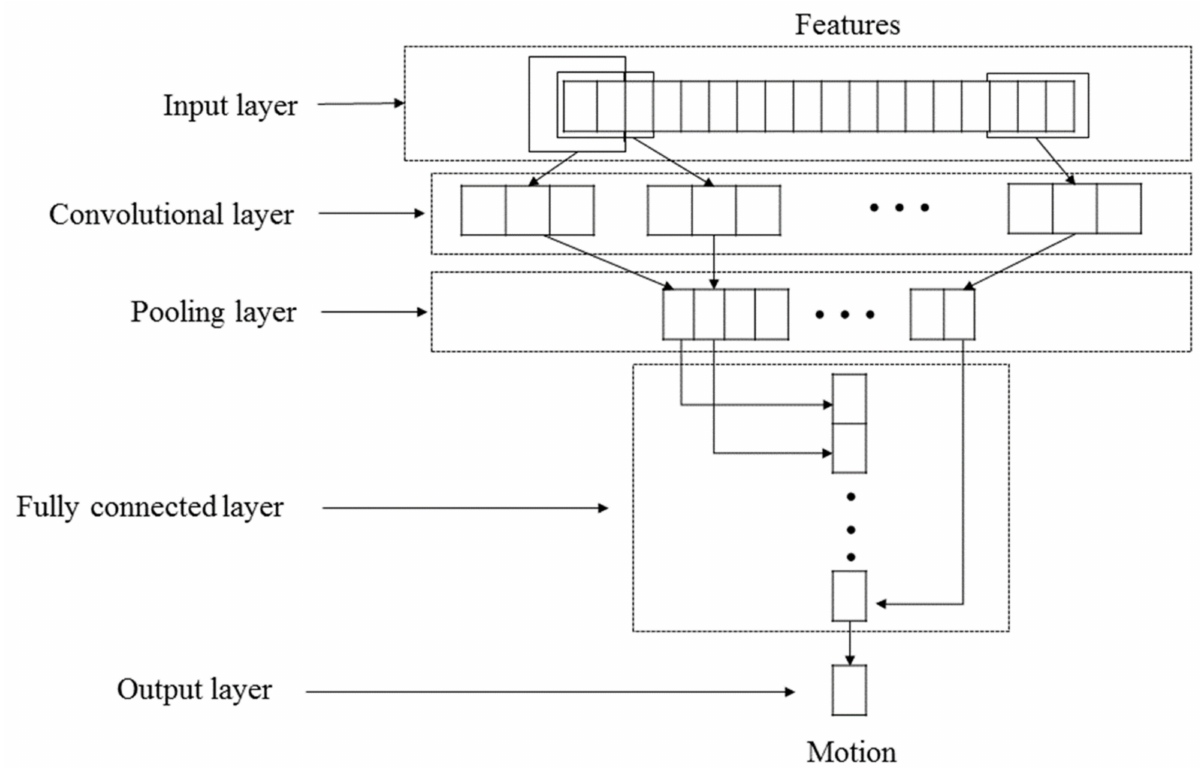
Figure 5. The basic architecture diagram of